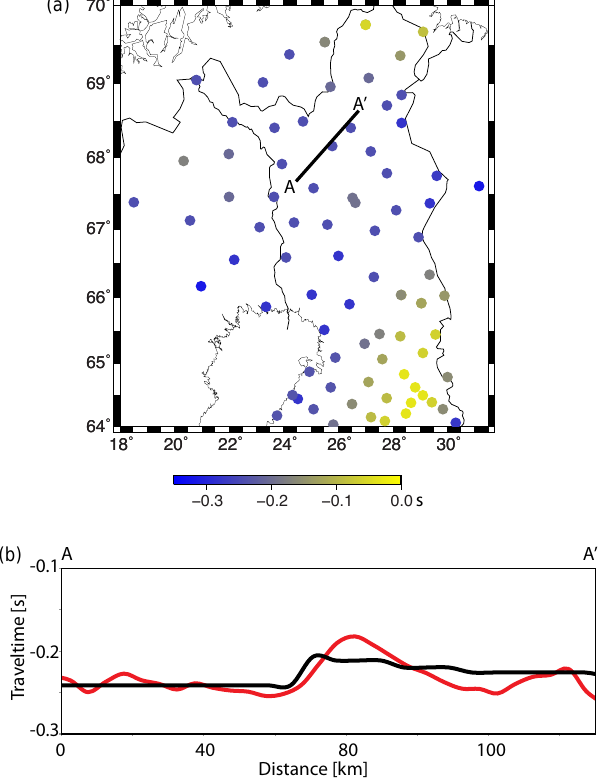
Figure 5. A comparison between data and model variance with dif- ferent damping values. The selected damping value was first found using one inversion round only and the results are shown with dia- monds with the damping value used shown on the right side of the symbols. The number of iterations was also optimized (dots with the number of iterations marked to their left side) for the selected damping value of 100. The final number of iterations, 4, is marked with a red circle. The grey line denotes the overall data uncertainty, 0.017s 2 , calculated as the average uncertainty of all observations.